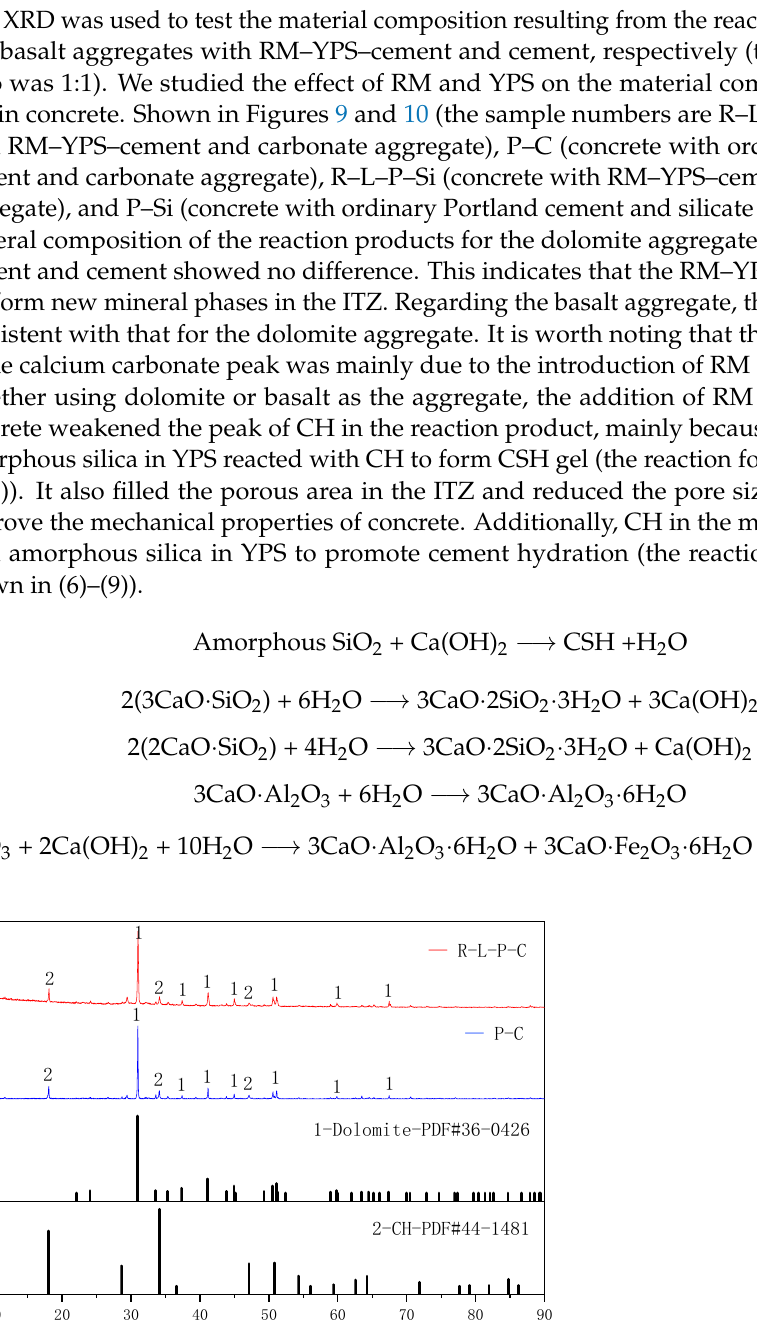
2θ(°) Figure 10. XRD patterns of the reaction product between basalt aggregate and cement materials (1: quartz ((SiO 2 ), 2: CH (Ca(OH) 2 ), 3: calcite (CaCO 3 )). 4. Conclusions We found a slight decrease in the concrete compressive strength when adding 10.00 wt.% of RM; when we added more than 10.00 wt.%, it decreased greatly. The mechanical properties of concrete for which cement was replaced with 10 wt.% RM and 9.00 wt.% YPS were better than when it was replaced with only 10 wt.% RM and 18.00 wt.% YPS. Regarding the basalt and dolomite aggregates, the concrete compressive strength of the RM–YPS–cement increased by 25.04% and 27.27%, respectively, at the curing age of 28 days. The crystal size of the ITZ in the concrete prepared with RM–YPS–cement was smaller, and the crystals adhered closely to the aggregate surface, which was beneficial for an effective occlusion between the cementitious materials and aggregates. Nonreac ‐ tive YPS and RM particles could fill micropores in the ITZ region. Meanwhile, the small particle size of RM and YPS resulted in large pores being divided into many small pores, which decreased the average pore diameter. Adding RM–YPS–cement increased the pore